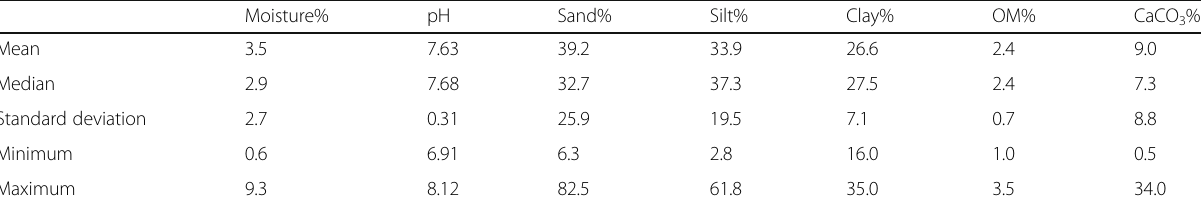
Table 1 Descriptive statistics of the physicochemical characteristics of the studied soils Moisture% pH Sand% Silt% Clay%